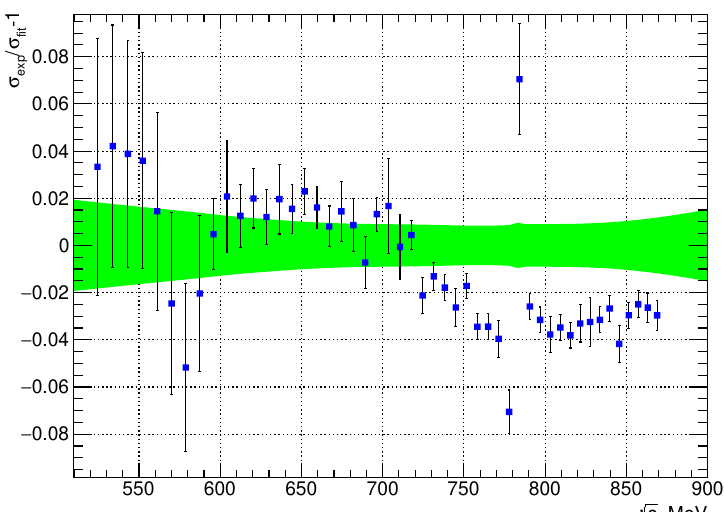
Figure 15 . The relative di(cid:11)erence between the e + e (cid:0) ! (cid:25) + (cid:25) (cid:0) cross section measured by KLOE [50] and the (cid:12)t to the SND data. The error bars take into account both statistic and systematical errors of KLOE data. The shaded area corresponds to the quadratic sum of the systematic and statistical errors of the SND.